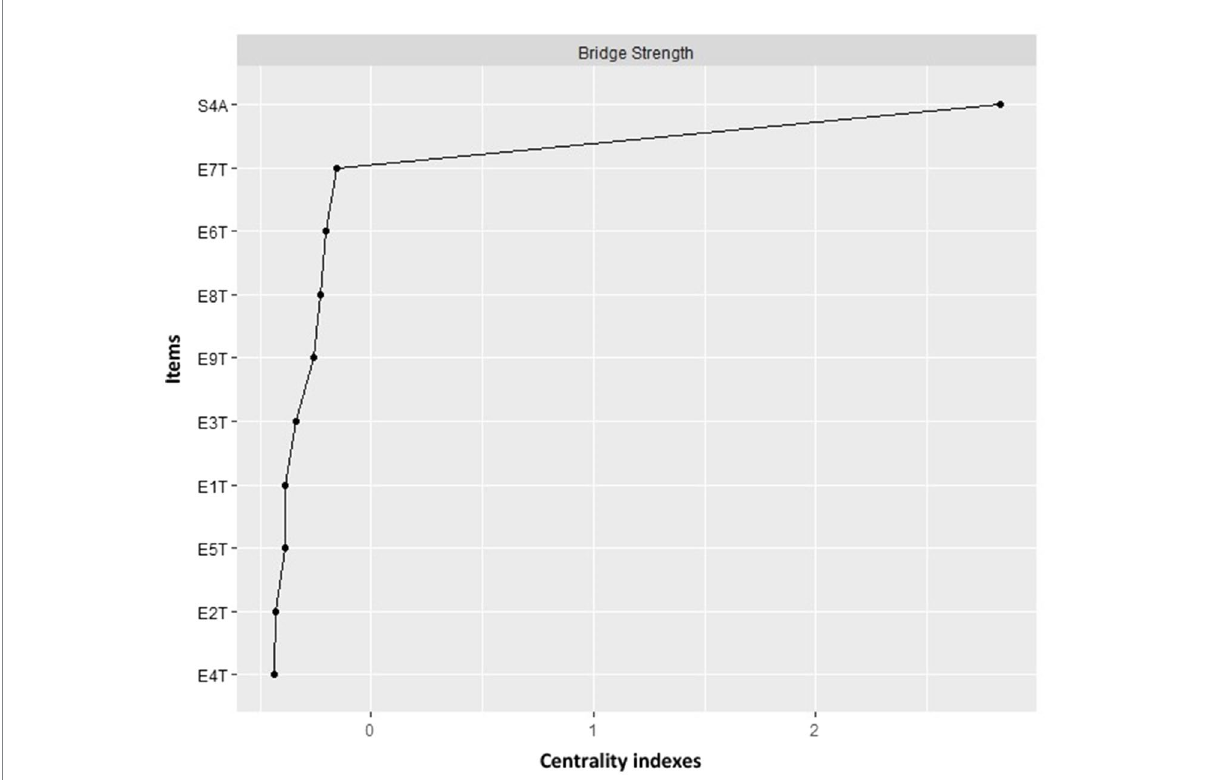
FIGURE 3 Network analysis bridge strength centrality index. Centrality refers to the measure with the highest number of connections together with the sum of the relationships it presents. T1: type 1; T2: type 2; T3: type 3; T4: type 4; T5: type 5; T6: type 6; T7: type 7; T8: type 8; T9: type 9; S4AT: healthy personality to psychosocial